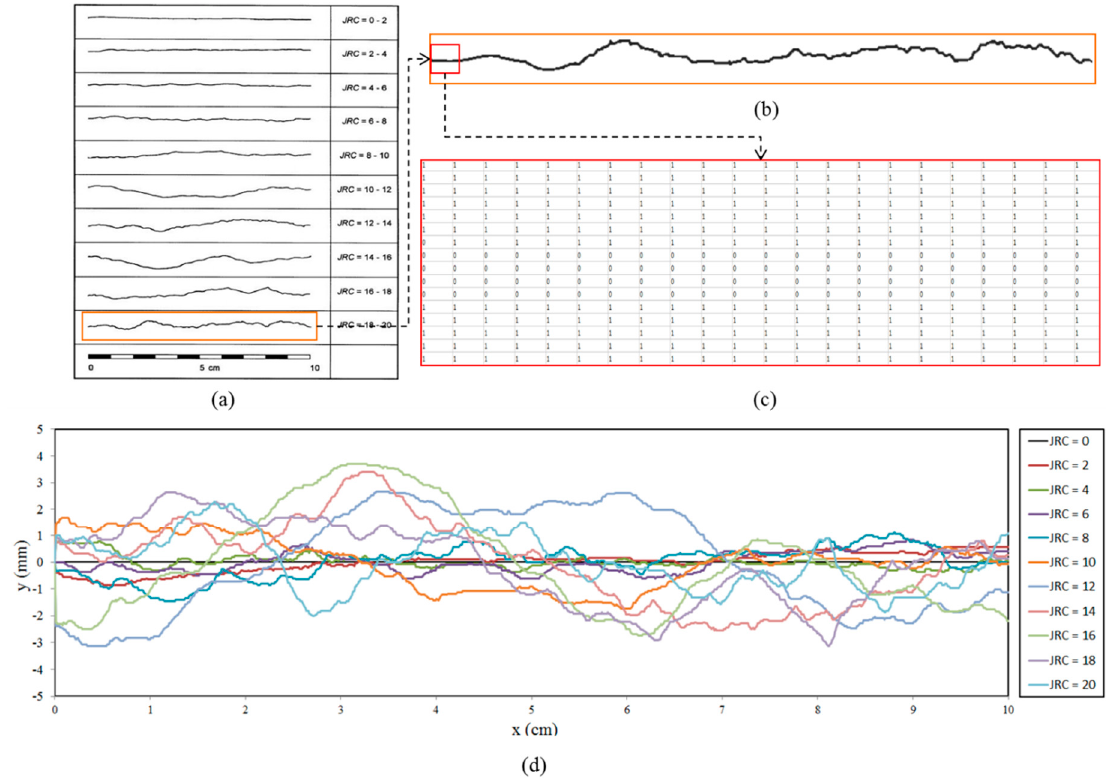
Figure 1. Process to obtain the height of Barton’s standard profiles: ( a ) Standard profiles from Barton et al. [28]; ( b ) Profile extraction; ( c ) Binarization of profile based on image processing; ( d ) Digitalization of the standard profiles according to the location of the black line (0) in the binarized image.